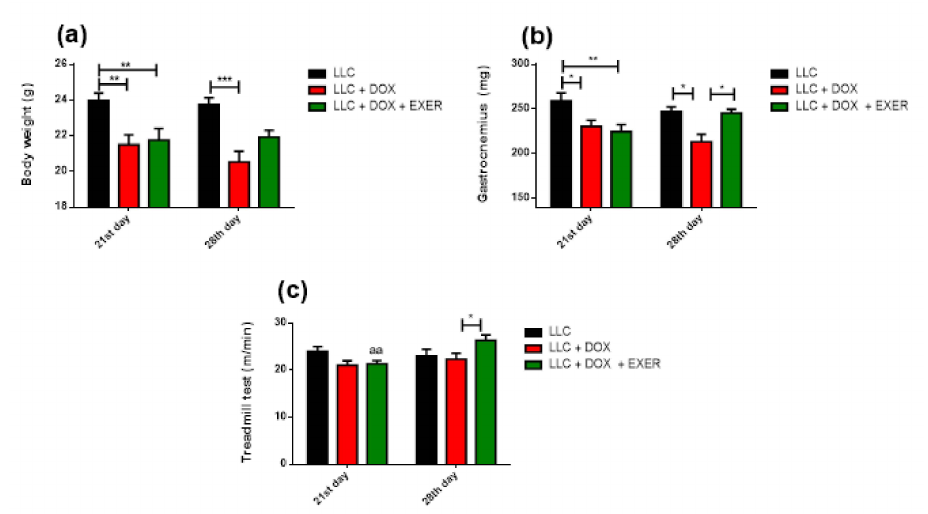
Figure 1. E ff ect of the association of endurance exercise with doxorubicin treatment on body weight gastrocnemius weight and treadmill performance immediately and delayed after the chemotherapy interruption. ( a ) Body weight (g), n = 9–15. ( b ) Weight of the gastrocnemius muscle (mg), n = 9–15. ( c ) Maximum speed on treadmill test (m / min), n = 9. Values represent the mean and standard error of the mean of the analysis of the data obtained. * p < 0.05; ** p < 0.01; *** p < 0.001; aa: p < 0.01 compared with the respective group on the 28th day. LLC = Lewis lung carcinoma; DOX = doxorubicin; EXER = endurance